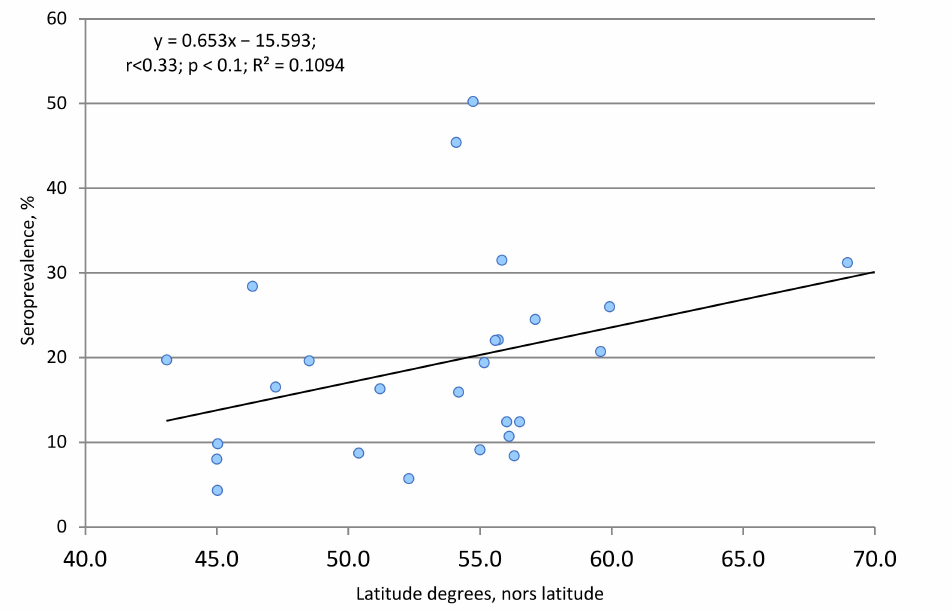
Figure 1. Correlation between geographical latitude of region and percent seroprevalence. The equation, regressions, correlation coefficient (r), statistical significance level ( p ), and determination coefficient (R 2 ) are shown. Geographic latitude is given for the center of the